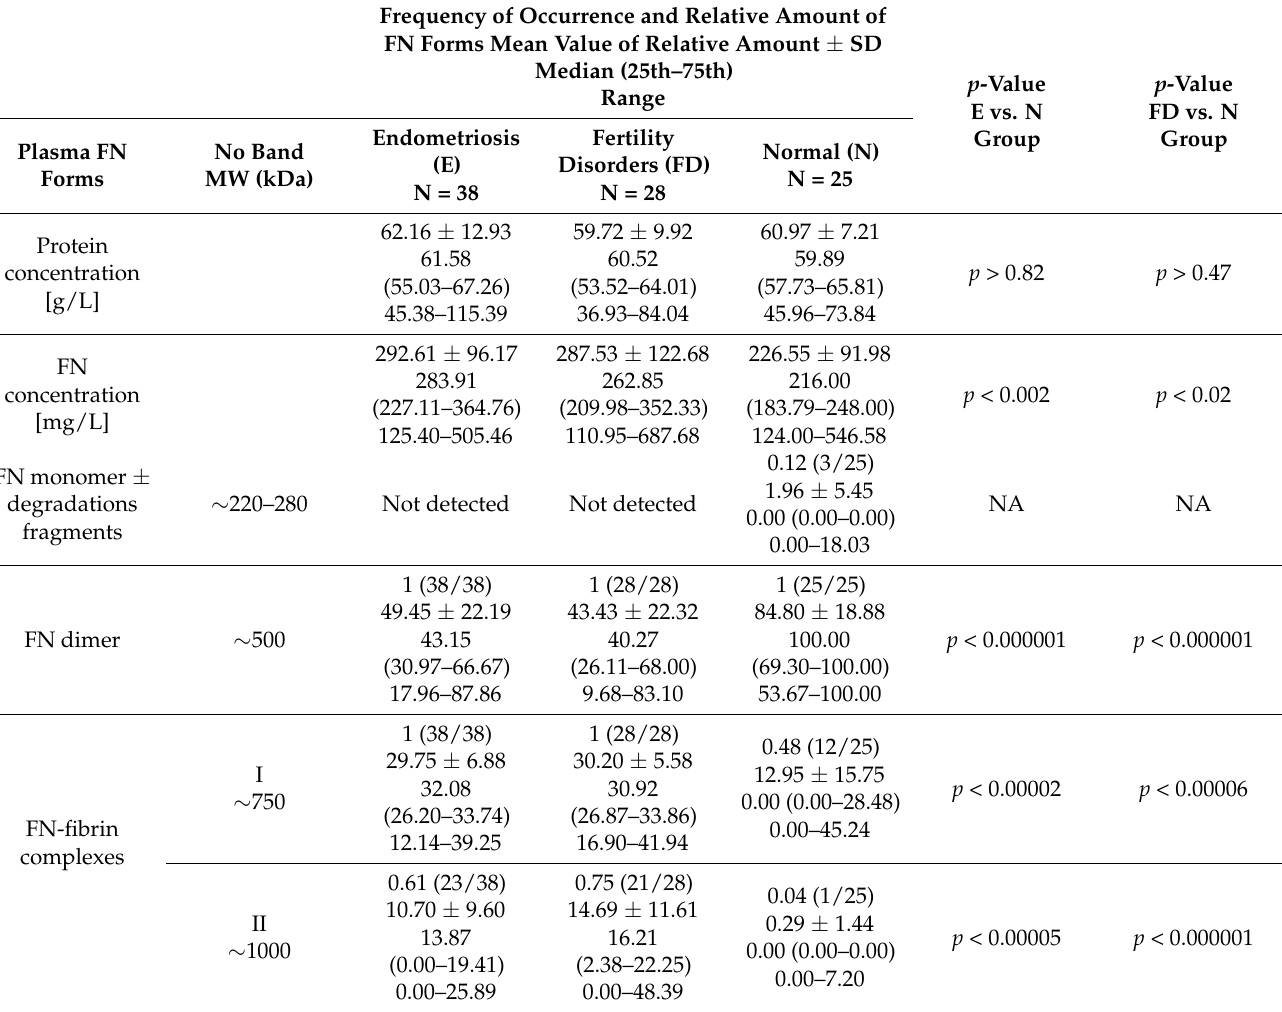
Table 2. Frequency of occurrence and relative amount of FN-fibrin complexes in blood plasma from women with en- dometriosis and fertility